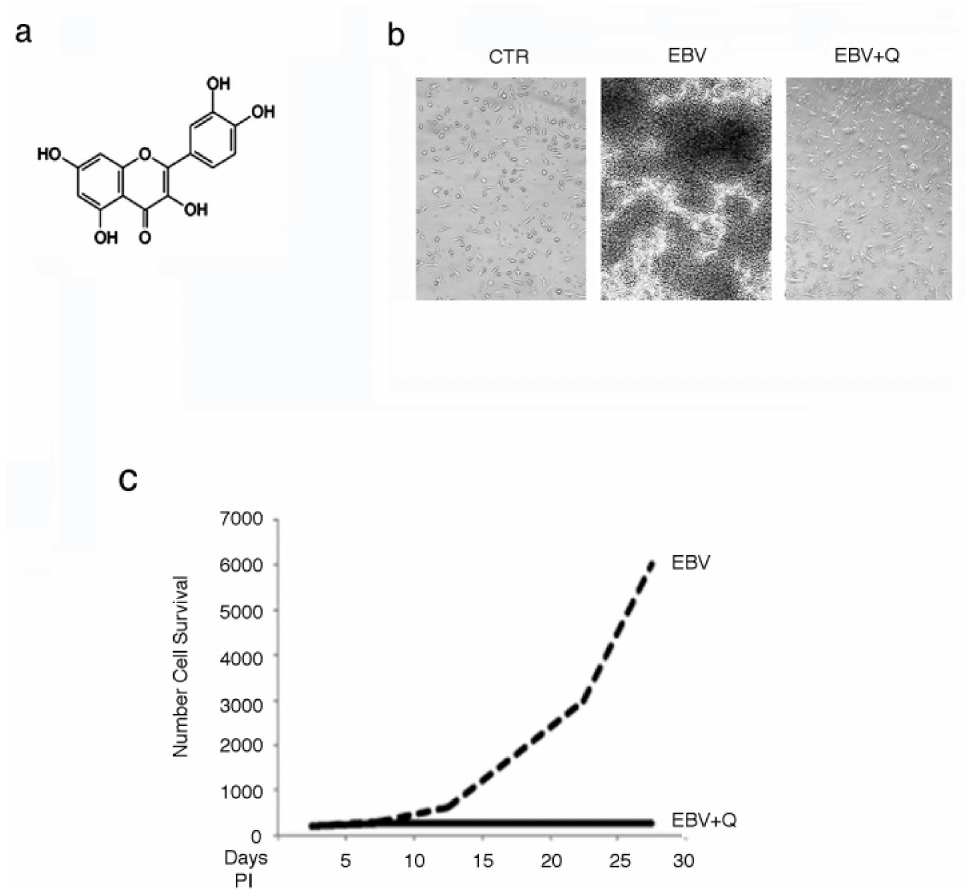
Figure 1. Quercetin (Q) prevents Epstein–Barr virus (EBV)-mediated B cell immortalization. ( a ) Quercetin structure, ( b ) optical microscope photos showing the inhibitory e ff ect of quercetin on lymphoblastoid cell line (LCL) formation, ( c ) Time-dependent growth curve, as evaluated by a trypan blue exclusion assay of EBV-infected B cells grown in the presence or in the absence of quercetin. A representative experiment out of three is shown. CTR (control); PI